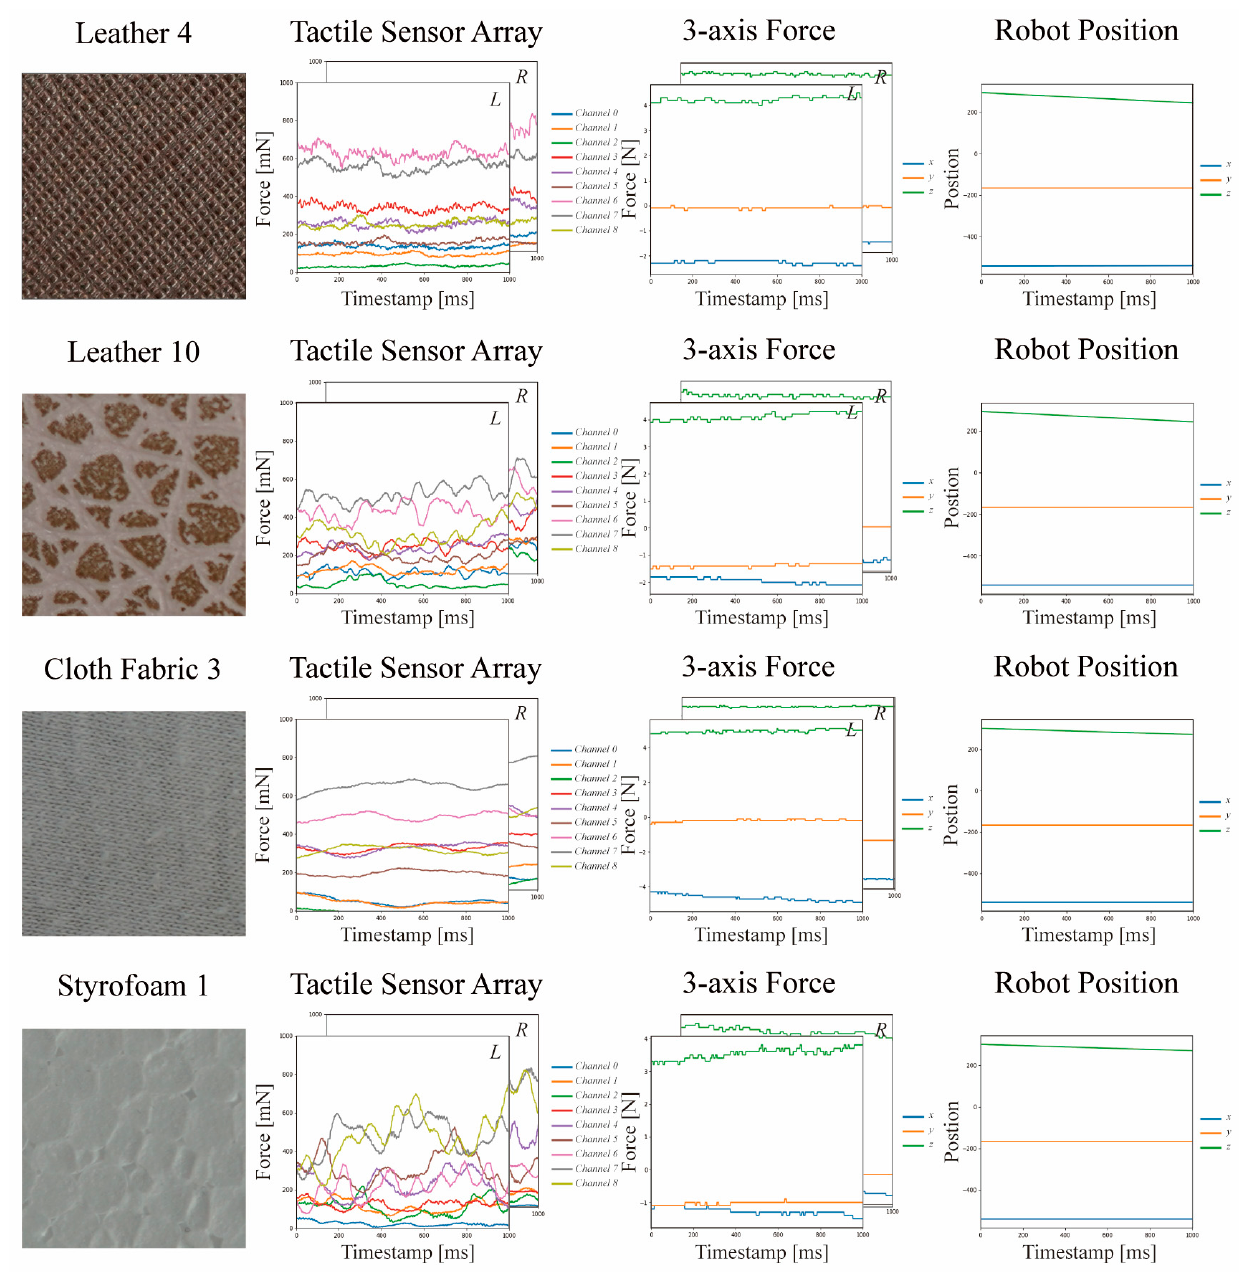
Figure 3. Examples of tactile surface exploration data for four textures (leather 4, leather 10, cloth fabric 3, and Styrofoam 1) out of the total twenty-four textures collected within the tactile sensing system. From left to right, the data were collected using a 3 × 3 tactile sensor array with nine channels, 3-axis force data, and robot position data.